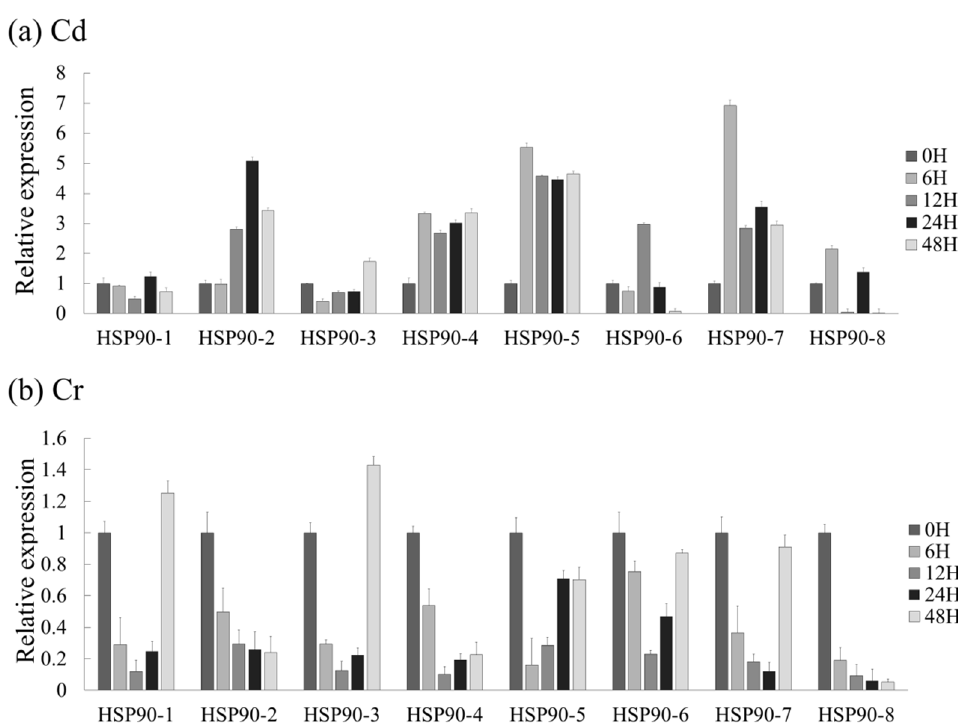
Figure 5. Expression patterns of LpHsp90s in response to ( a ) Cd and ( b ) Cr treatment. The values are the mean values of expression (n = 3).